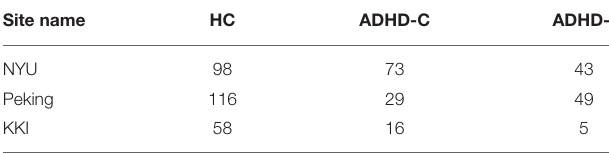
TABLE 12 | Number of subjects provided by three sites in the ADHD